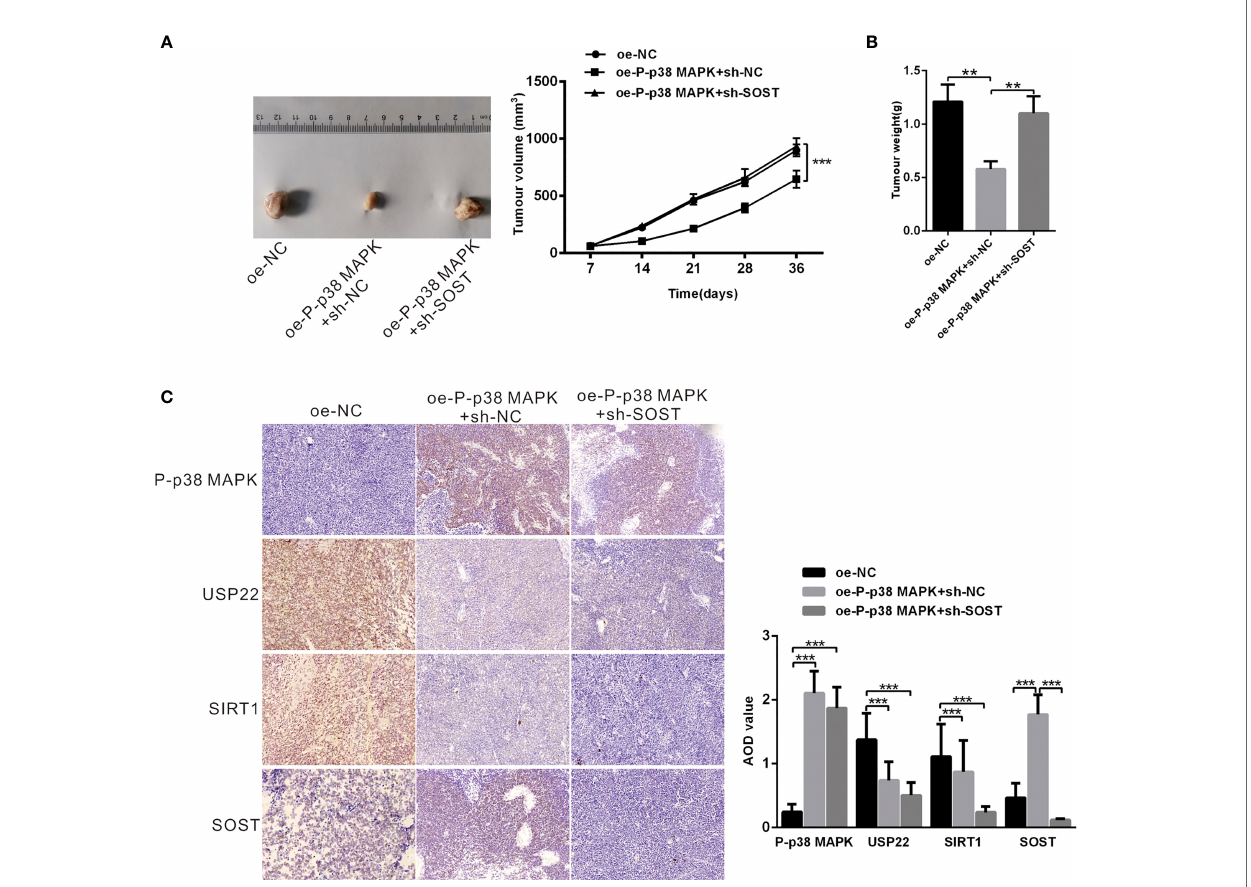
FIGURE 7 | P-p38 MAPK inhibits the development of RB by USP22/SIRT1/SOST axis in vivo . (A) tumor formation in mice injected with plasmids expressing oe-NC + sh-NC, oe-P-p38 MAPK + sh-NC or oe-P-p38 MAPK + sh-SOST was observed (n = 15). Tumor growth curve was drawn. (B) Tumor weight was recorded. (C) P- p38 MAPK, USP22, SIRT1 and SOST expression in tumor tissues was measured using IHC assay. ** p < 0.001, *** p < 0.001. The measurement data was expressed by mean ± standard deviation. The two groups of data conforming to the normal distribution were compared using unpaired t